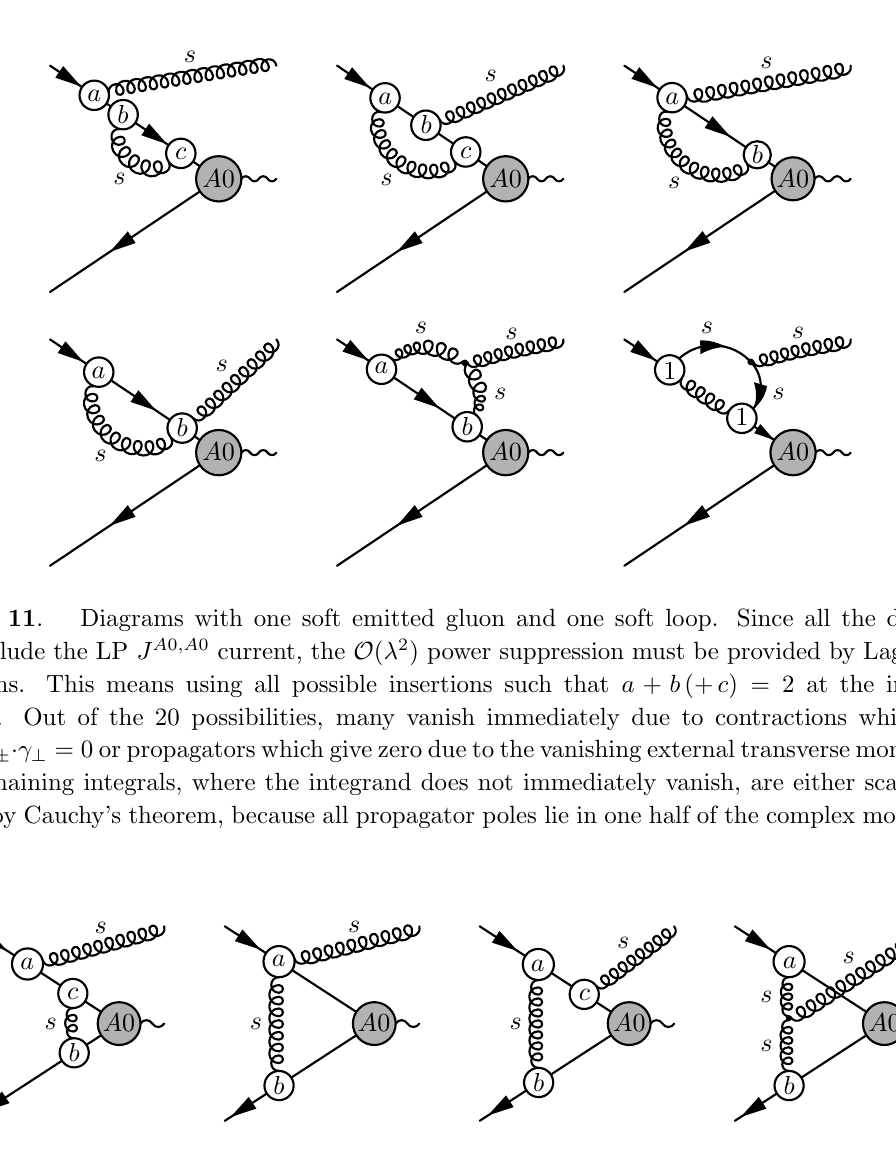
Figure 12 . Soft one-loop diagrams with one emitted soft gluon. As in the previous (cid:12)gure, only the LP current is present in these diagrams, however now the virtual soft gluon connects the collinear and anticollinear legs. Lagrangian insertions must again be chosen such that a + b (+ c ) = 2. Note that all diagrams with b = 1 vanish, since a single leg cannot carry a ( (cid:21) ) suppression as explained O in section 3.2. Only the last diagram with a = 2 or b = 2 gives a non-vanishing result. The others are either scaleless or vanish after momentum conservation is